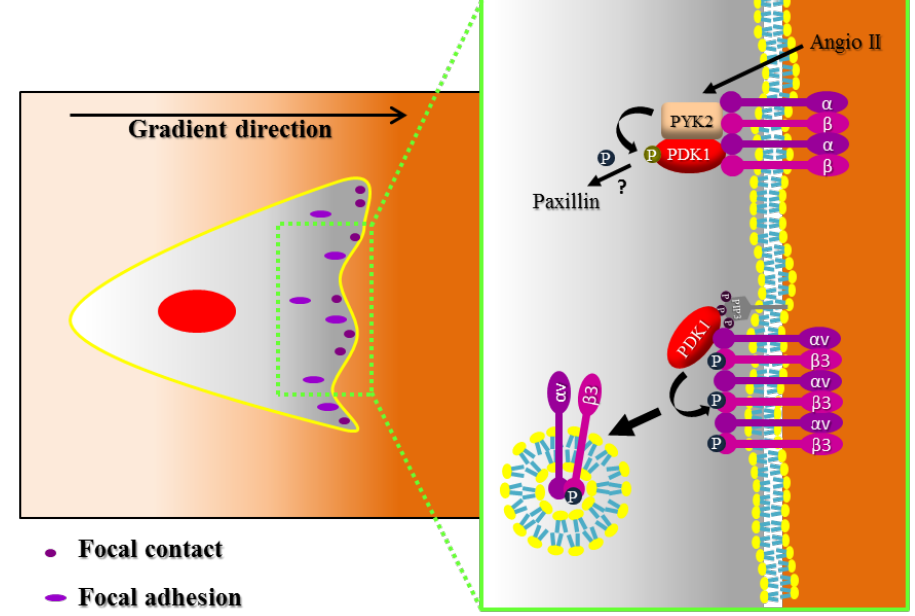
Figure 4. PDK1 regulates focal adhesion and integrin signaling. For migration to occur, the protrusions must stabilize by attaching to the substratum through integrin-mediated adhesions. Adhesions assemble as small clusters of integrins, known as focal complexes, which stabilize the lamellipodium, and then eventually mature in more stable focal adhesions or turn over. PDK1 has been shown to localize to focal adhesions together with Pyk2 and to regulate them, possibly by phosphorylating effectors such as paxillin, through an unknown mechanism. Moreover, downstream to PI3K, PDK1 regulates focal adhesion disassembly, by phosphorylating integrin β 3 and thus by inducing its endocytosis. ? refers to unknown mechanism of phosphorylation